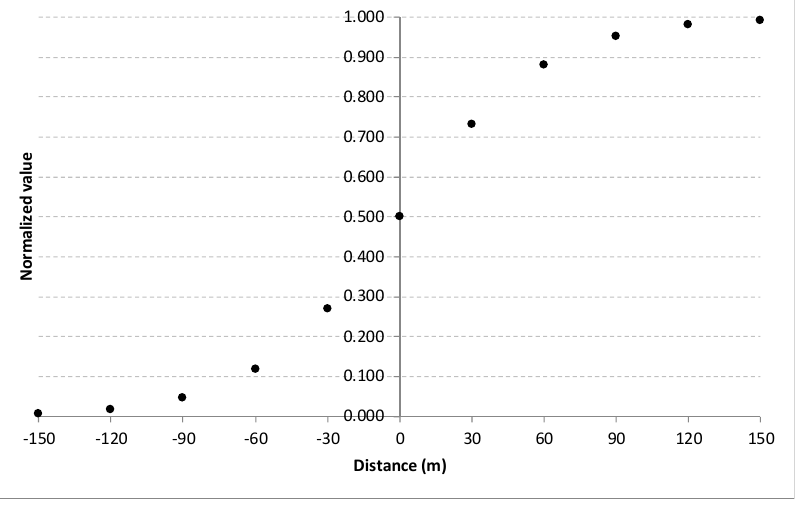
Figure 6. The effect of focused